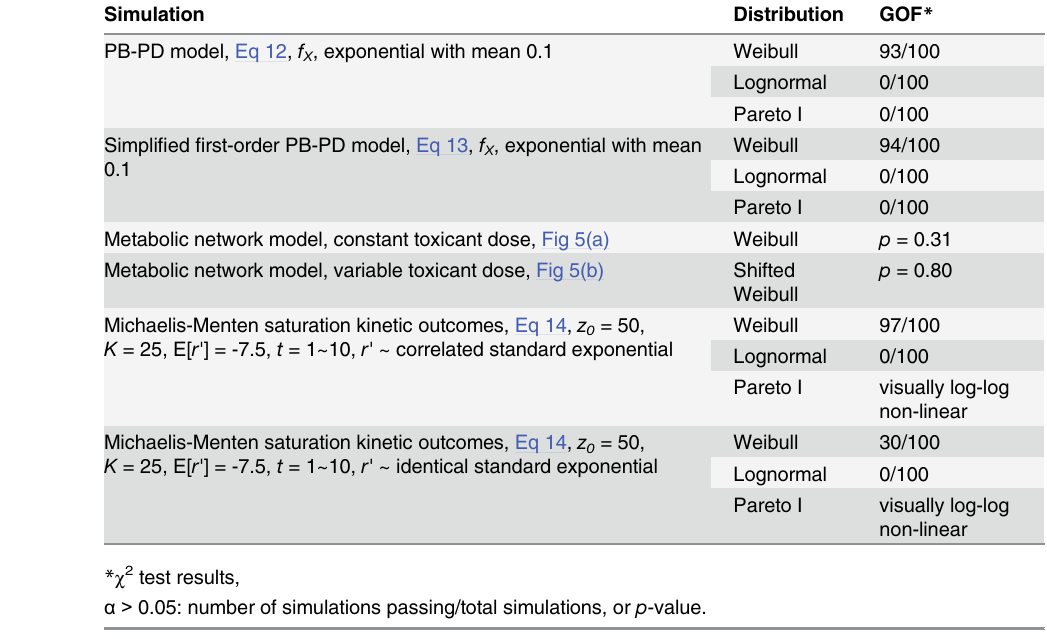
Table 1. Simulation GOF results.